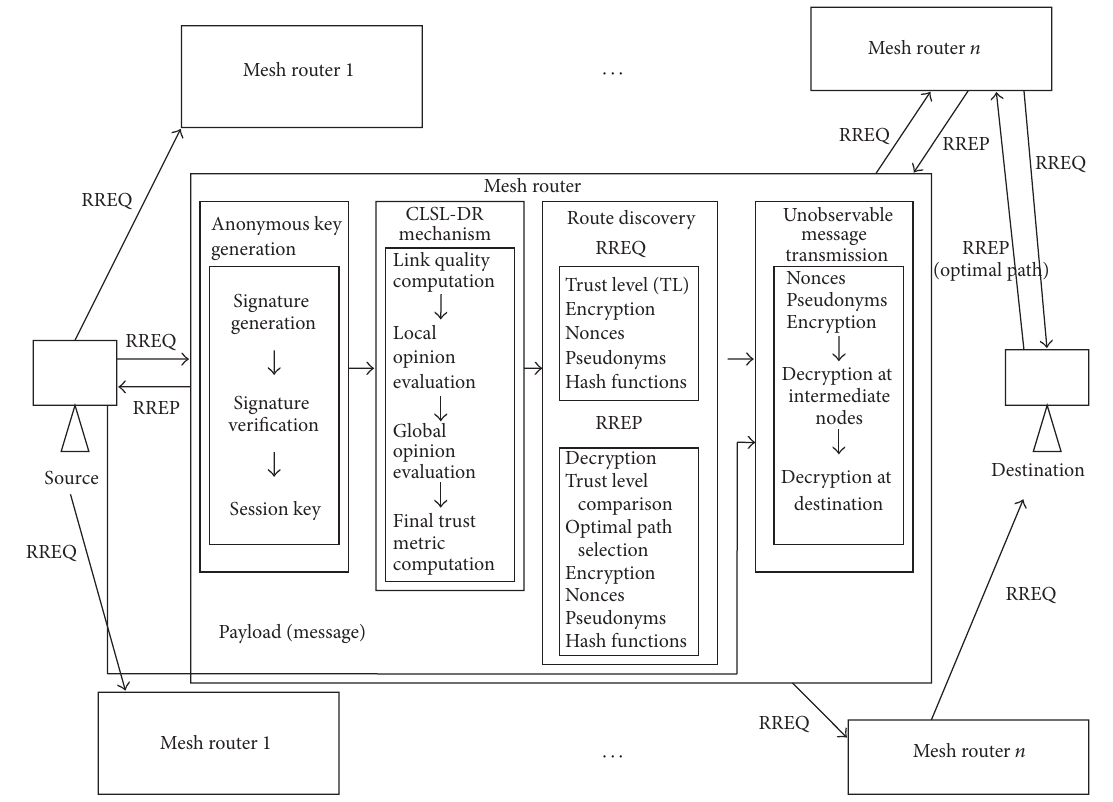
Figure 1: Functional components of